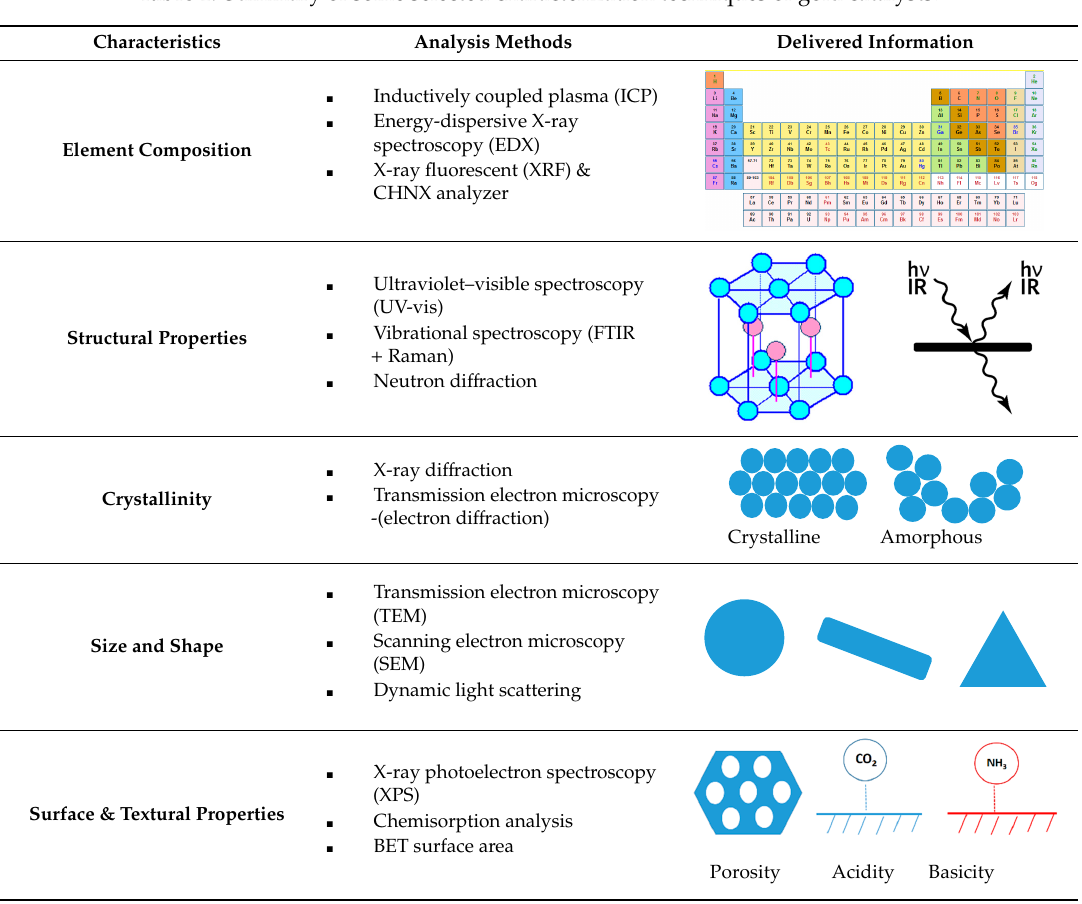
Table 1. Summary of some selected characterization techniques of gold catalysts.